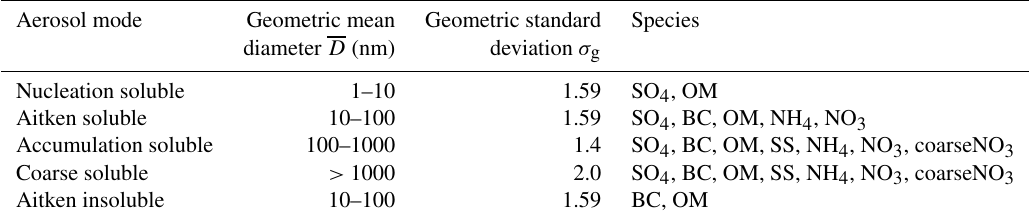
Table 1. Properties of the aerosol size distribution in the nitrate UKCA-mode setup including the size range of the modes, the geometric standard deviation, and the permitted aerosol species in each mode. Species include sulfate (SO 4 ), black carbon (BC), organic matter (OM), and sea salt (SS) as well as the newly added ammonium (NH 4 ), nitrate (NO 3 ), and coarse nitrate (coarseNO 3 ). Adapted from Table 1 in Mulcahy et al.